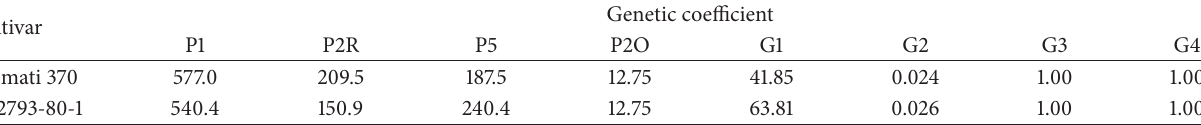
Table 2: Calculated genetic coefficients for Basmati 370 and IR 2793-80-1 .